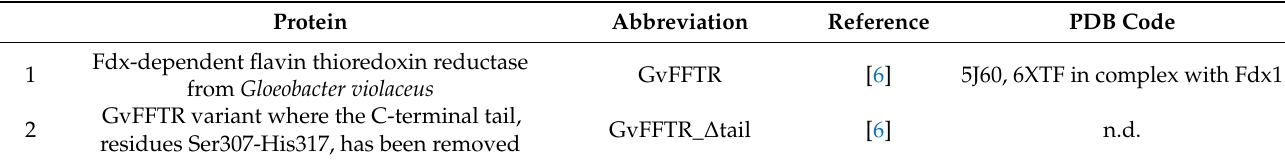
Table A1. List of proteins used in this